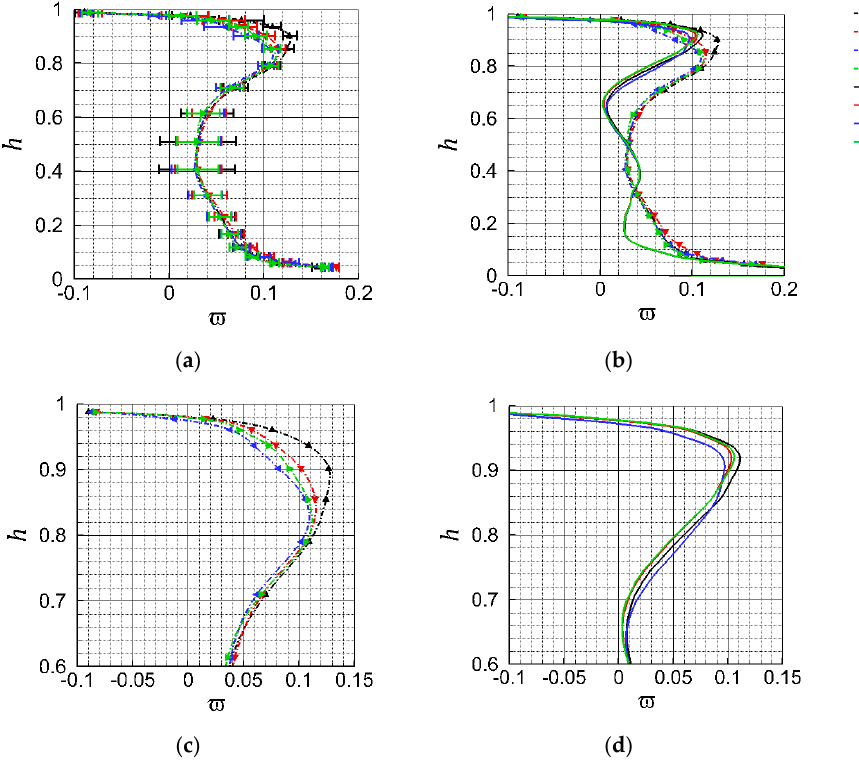
Figure 18. Comparisons of the loss coe ffi cients obtained from numerical and test results. ( a ) Test results with error band. ( b ) Comparison for the numerical and test results of the whole blade height. ( c ) Test results from 0.6 h to the tip of the blade. ( d ) Numerical results from 0.6 h to the tip of the blade. Table 6. Optimization results of the relative reduction values for di ff erent loss coe ffi cients under di ff erent optimization schemes compared with the axisymmetric shroud stator (test results).